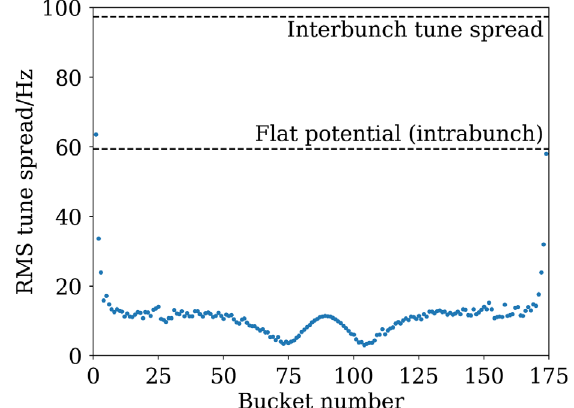
FIG. 13. Bunch length for different bucket numbers for three different Landau-cavity voltages that appear in Fig. 9.